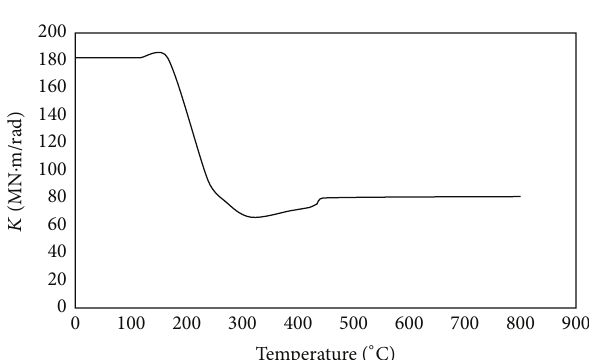
the heat. The displacement of a steel structure is because of the main steel members exposed to fire. The connection with the end plate has better performance than other common steel